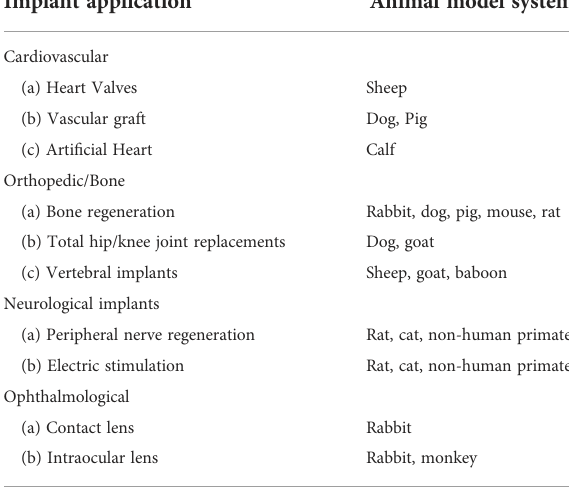
TABLE 3 Animal model for in-vivo implants experiments. Implant